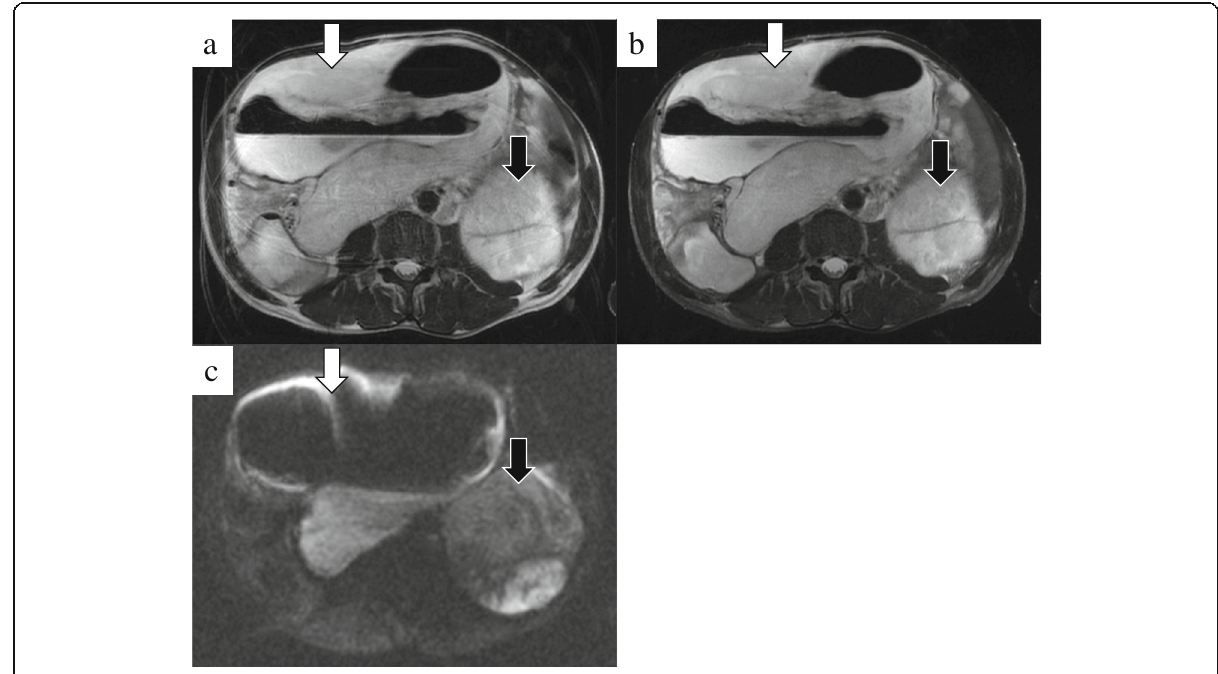
Fig. 2 Non-contrast abdominal magnetic resonance image. a The solid part of both intra-abdominal (white arrow) and retroperitoneal (black arrow) masses showed inhomogeneously high intensity in T2-weighted imaging (T2WI). b Both masses also showed almost the same pattern as T2WI in fat saturation T2WI. c Both masses also showed inhomogeneously high intensity in diffusion-weighted